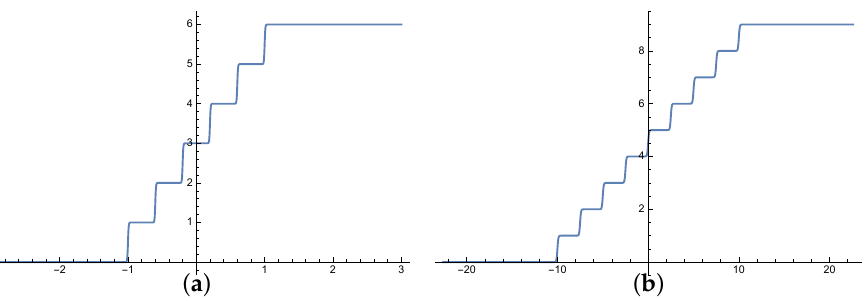
Figure 1. SS activation function ( a ) number of steps n = 6 and boundary value b = 1. ( b ) number of steps n = 9 and boundary value b = 10.